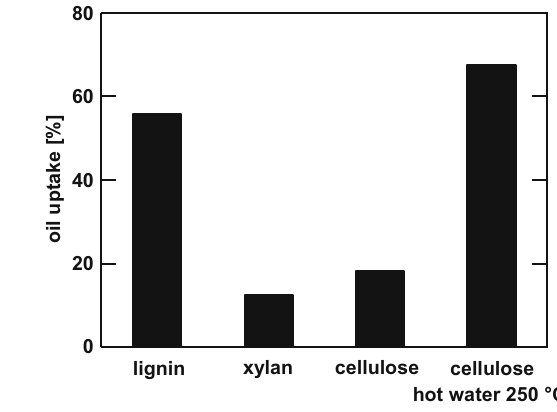
Figure 5: Oil uptakes for the pure biomass components and the cellulose treated in hot